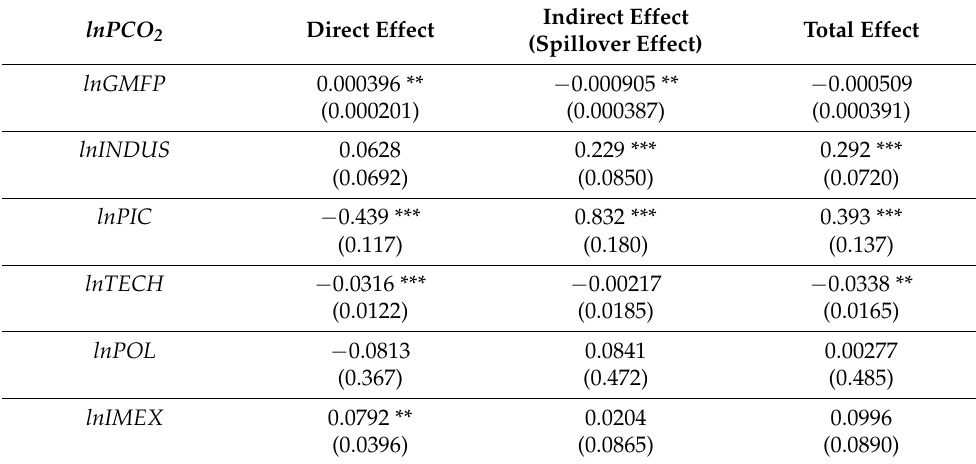
Table 5. Decomposition